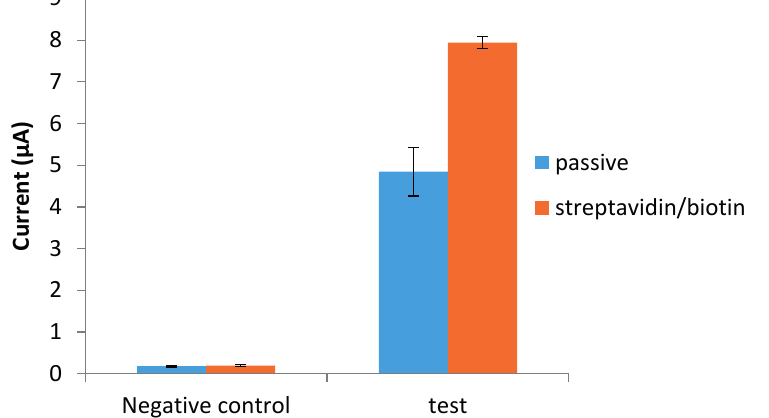
Figure 3. Immobilization of anti-NS1 capture antibody via passive adsorption and streptavidin/biotin